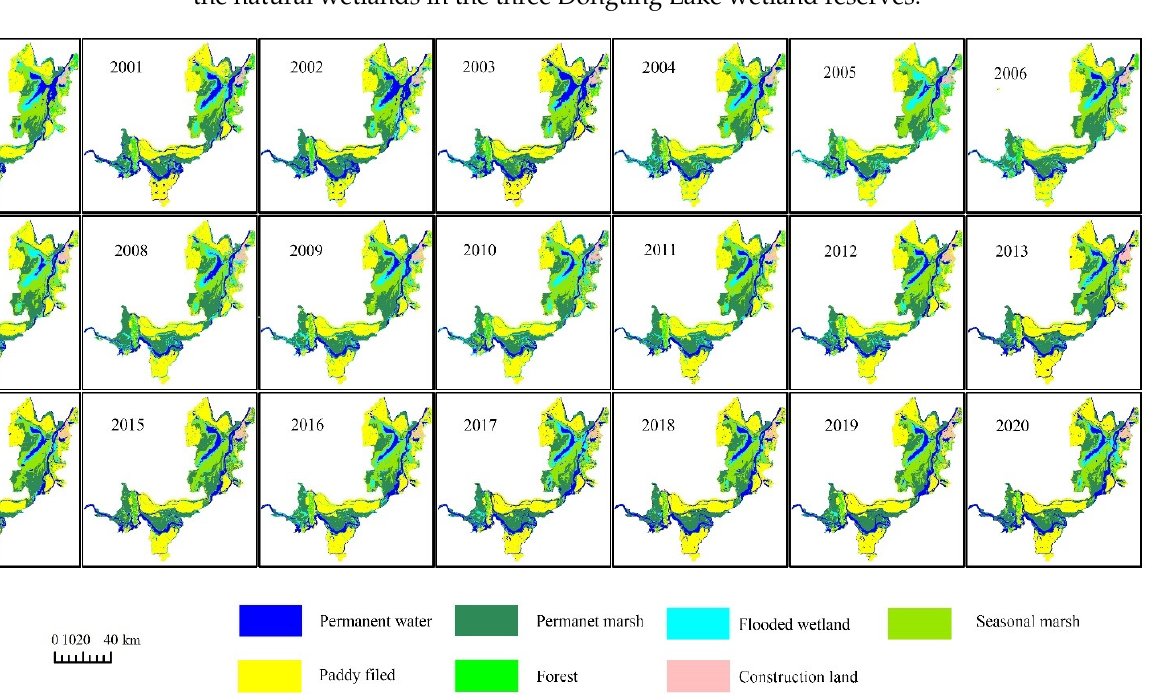
Figure 11. Spatiotemporal distribution of classification results of the three Dongting Lake wetland reserves from 2000 to 2020.